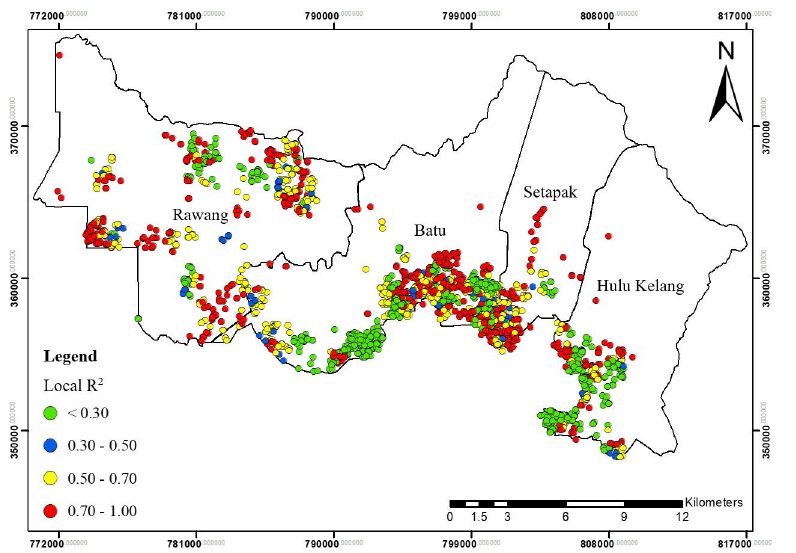
Fig 13. Spatial distribution of local R 2 for GWR3 in Gombak, 2013 to